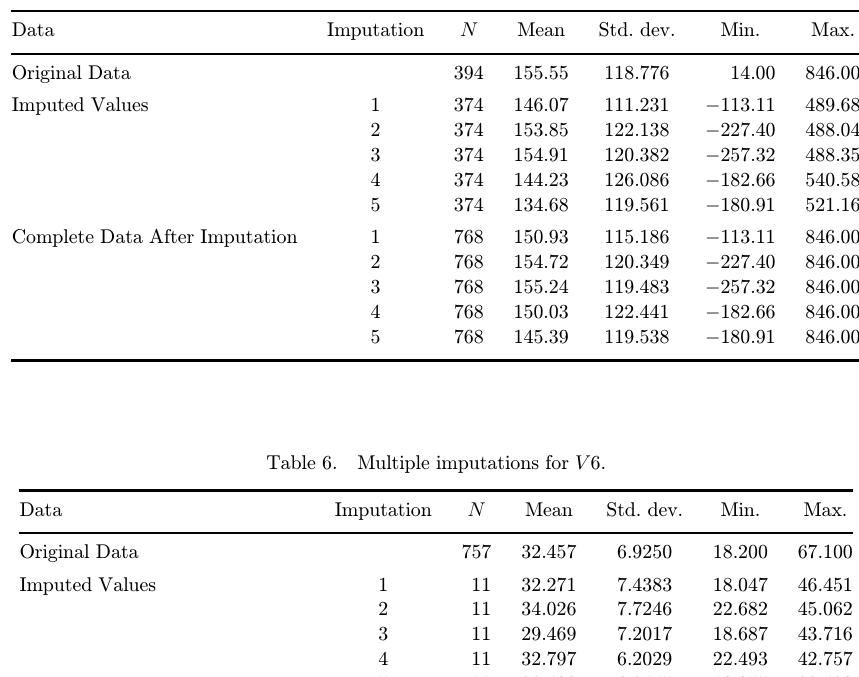
Table 5. Multiple imputations for V 5.